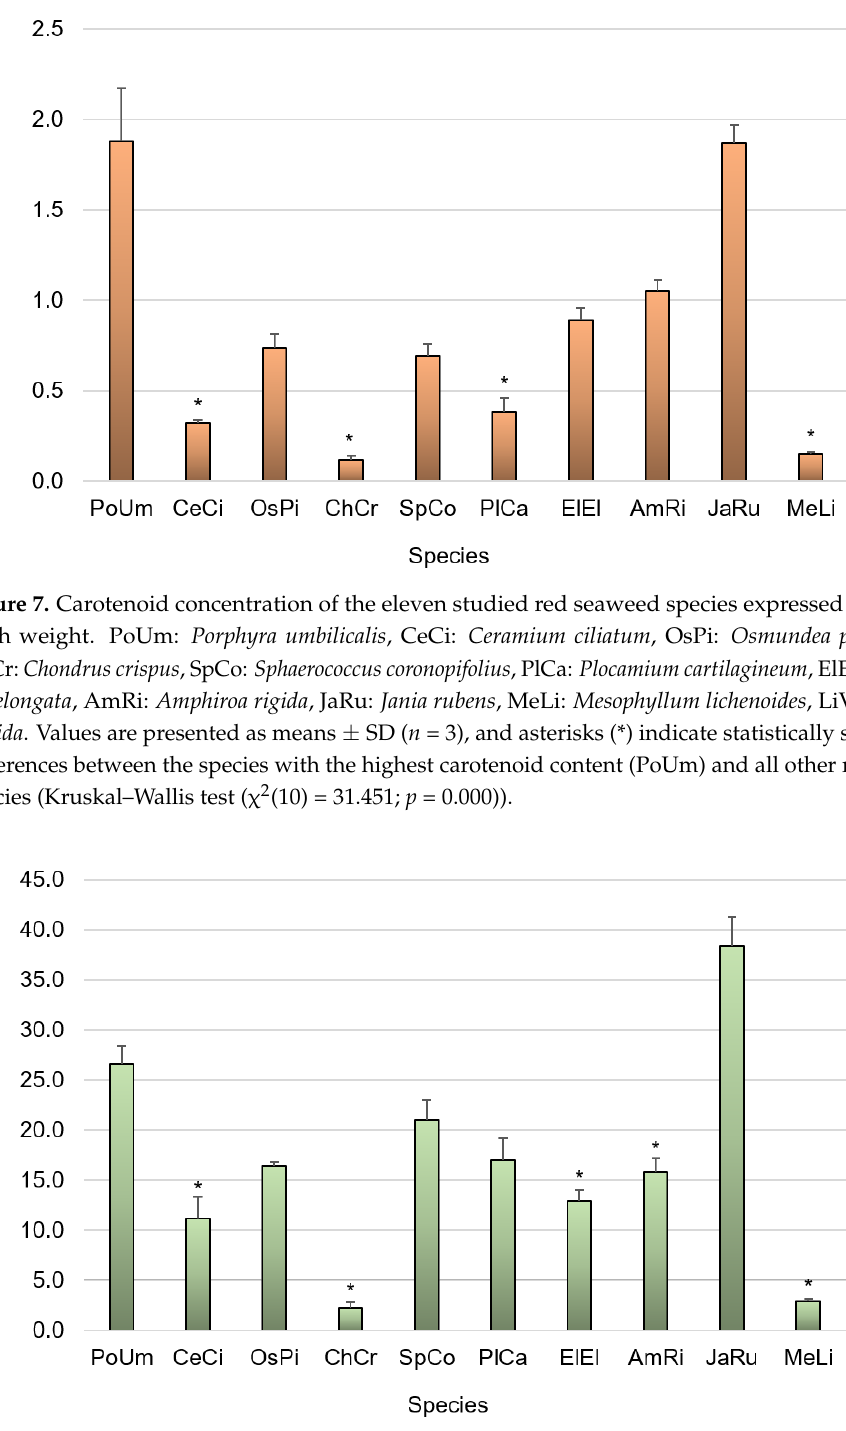
Figure 8. Chlorophyll a concentration of the eleven studied red seaweed species expressed in µ g.mL − 1 fresh weight. PoUm: Porphyra umbilicalis , CeCi: Ceramium ciliatum , OsPi: Osmundea pinnatifida , ChCr: Chondrus crispus , SpCo: Sphaerococcus coronopifolius , PlCa: Plocamium cartilagineum , ElEl: Elisolandia elongata , AmRi: Amphiroa rigida , JaRu: Jania rubens , MeLi: Mesophyllum lichenoides , LiVi: Liagora viscida . Values are presented as means ± SD ( n = 3), and asterisks (*) indicate statistically significant differences between the species with the highest chlorophyll a content (JaRu) and all other remaining species (Kruskal–Wallis test ( χ 2 (10) = 30.930; p =